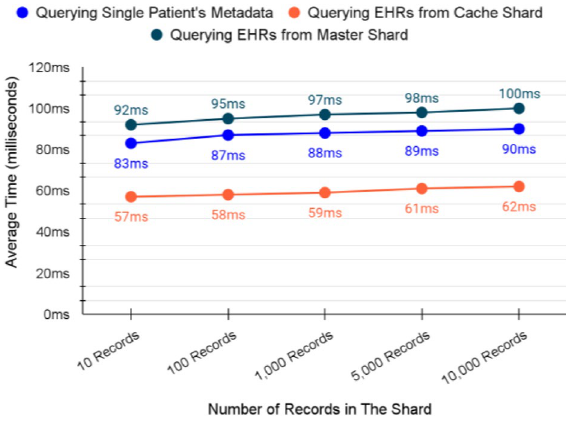
Figure 19. Queries validation in milliseconds.